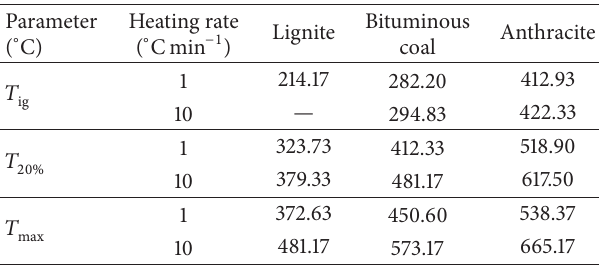
Table 2: Reactivity indexes characterizing oxidation reactivity of different rank